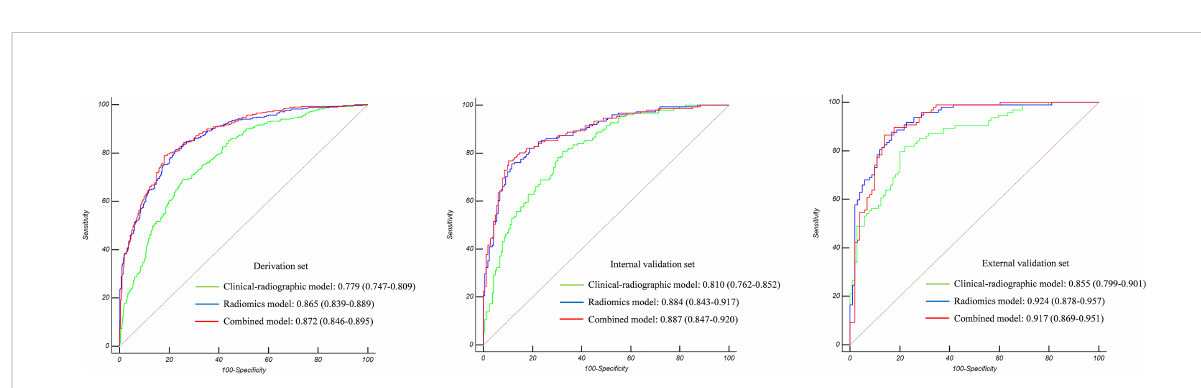
FIGURE 3 The Az value of the three models in the derivation set, internal validation set, and external validation set. Radiomics showed superior predictive performance than clinical-radiographic models in all sets; however, the combined models showed comparable predictive performance to the radiomics